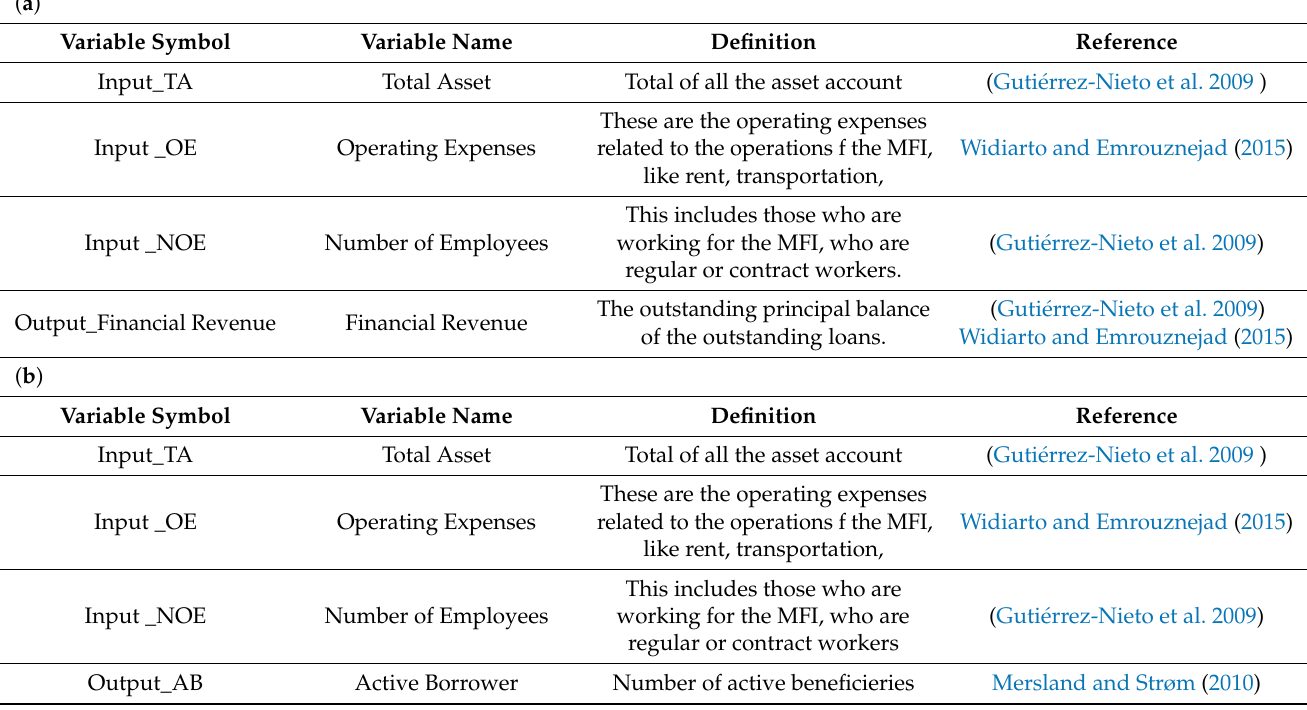
Table 2. ( a ) Input and output combinations for financial efficiency estimation; ( b ) Input and output combinations for social efficiency